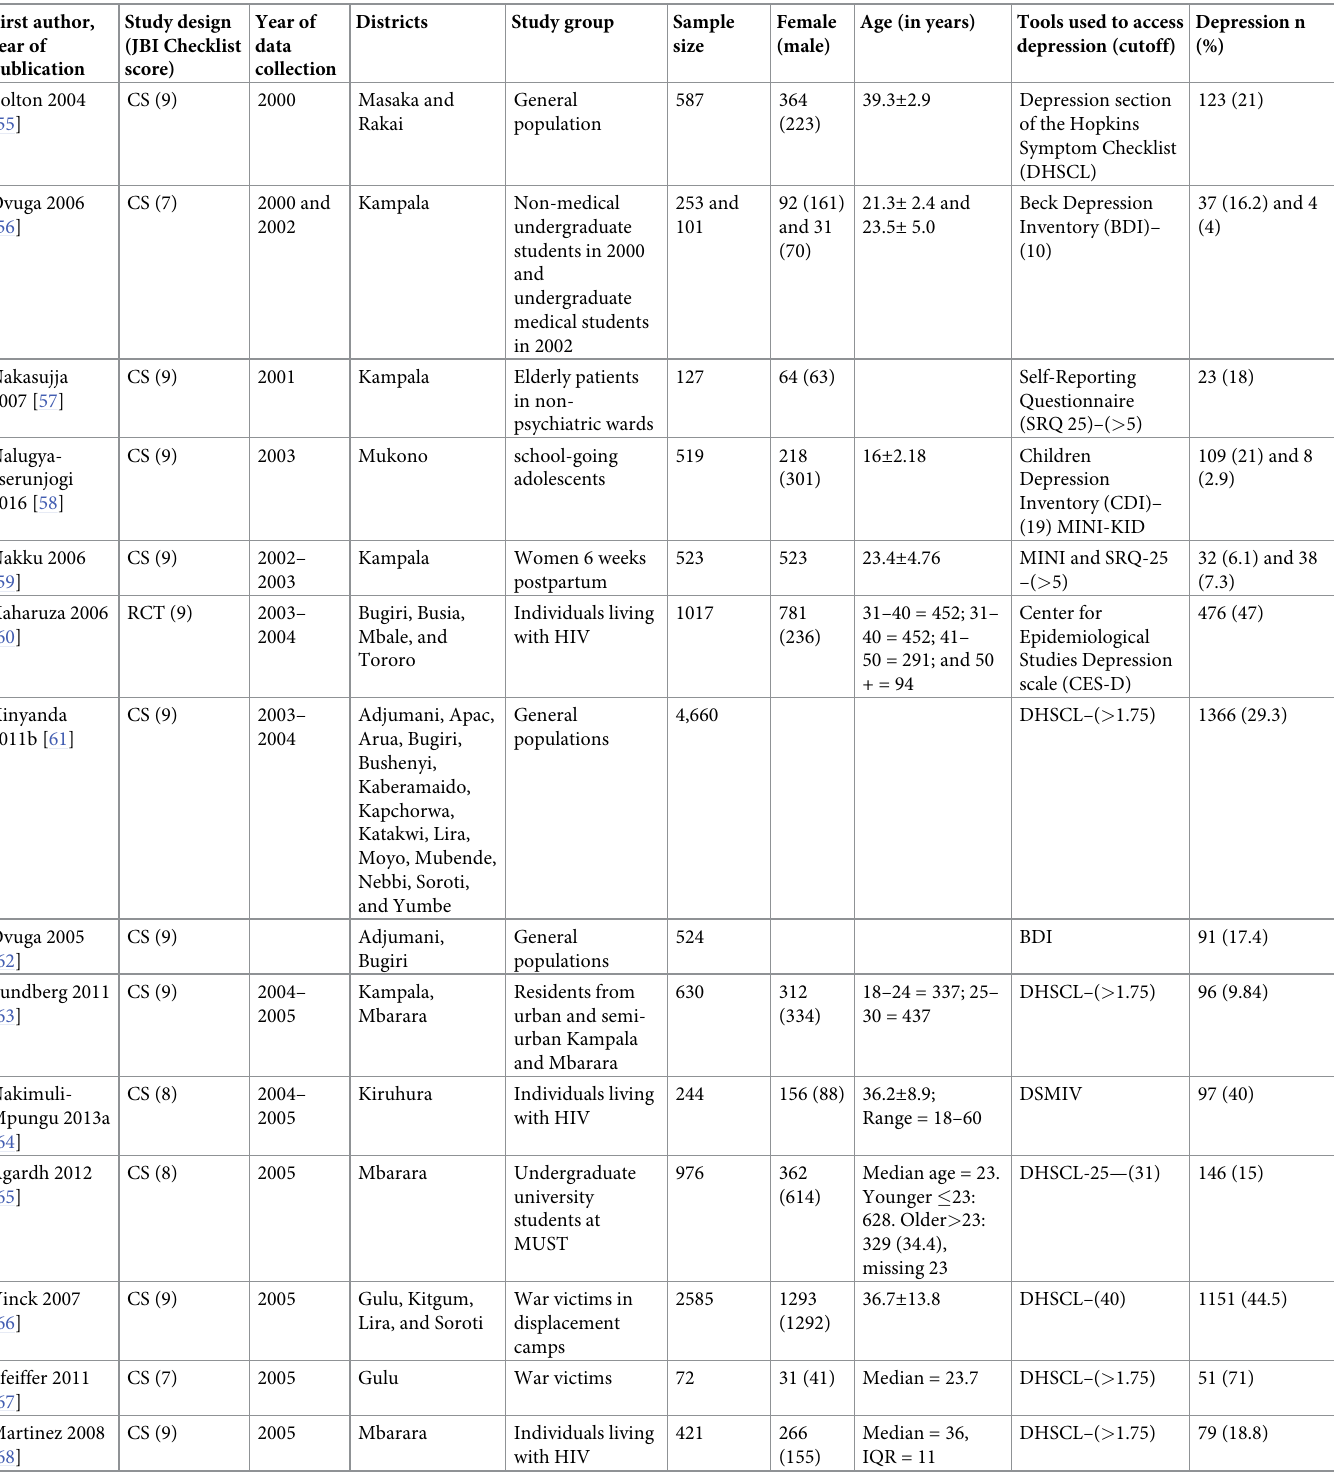
Table 1. Participants’ characteristics of all studies included in the